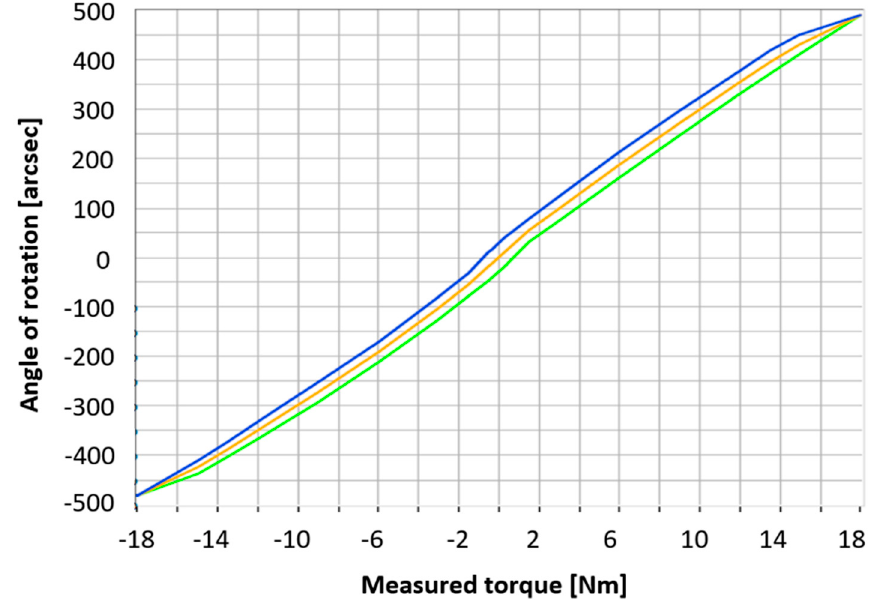
Figure 13. Course of hysteresis curve BR TS 050-63, s/n.1901 after 48 h-long trial run.